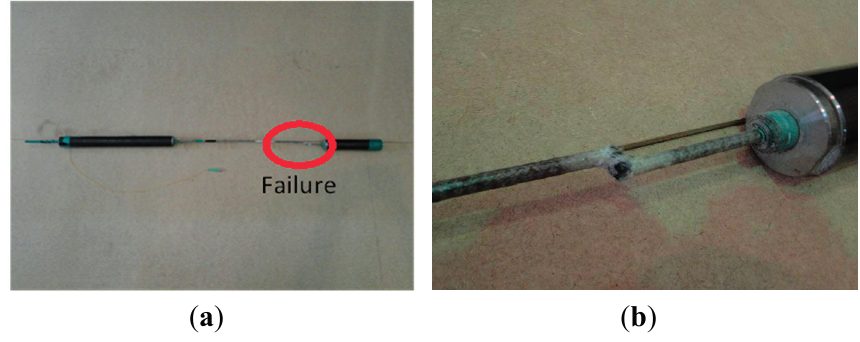
Figure 6. ( a ) Failure pattern of carbon core wire specimens and ( b ) detailed view.